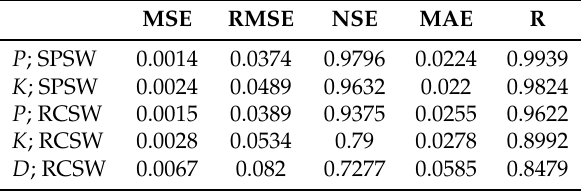
Table 6. Comparison of five statistical indicators to evaluate the accuracy of meta-models.